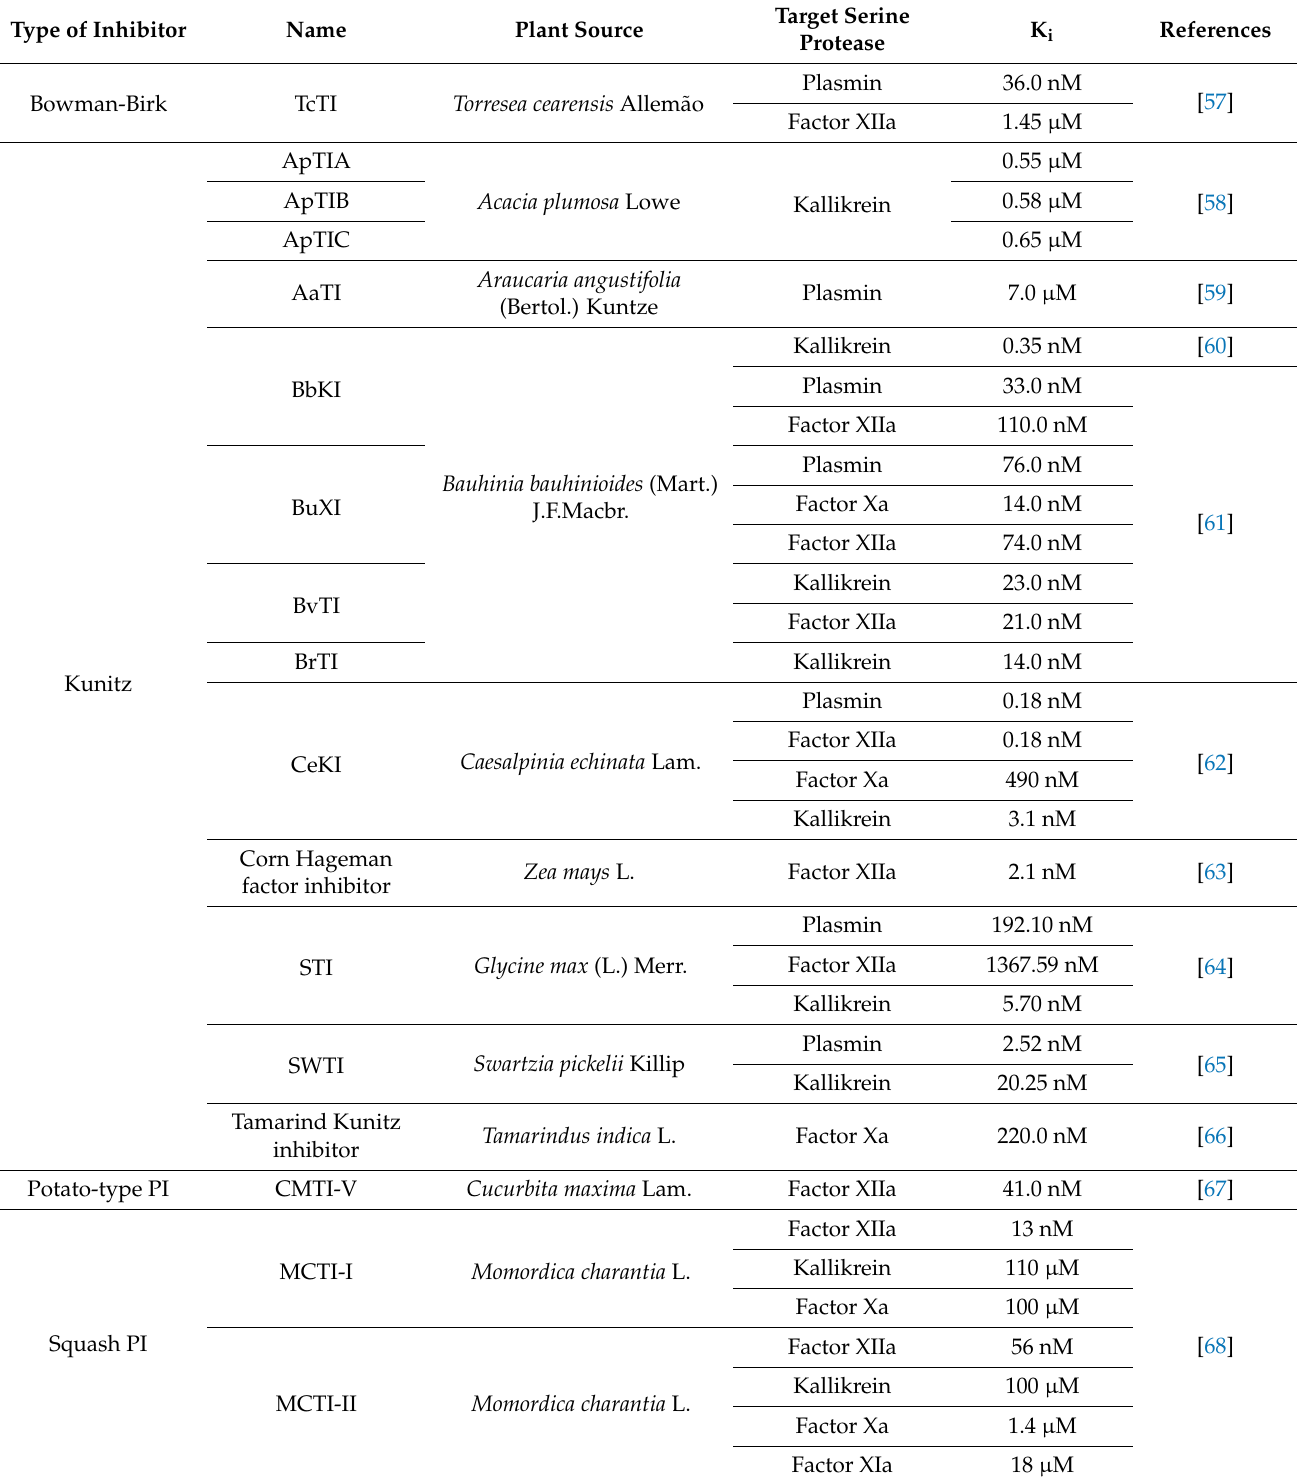
Table 4. Peptide-based plant inhibitors of serine proteases of the blood coagulation cascade and fibrinolytic